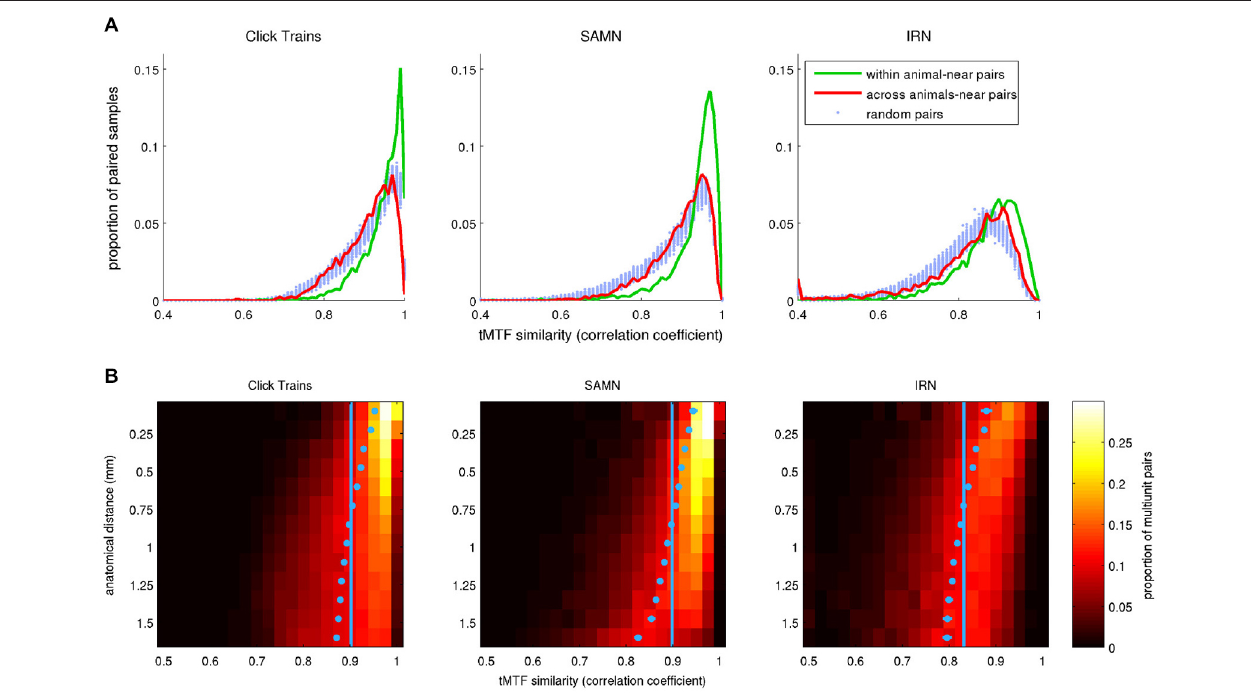
on anatomical distance. In the heat maps, each row shows the distribution of correlation coefficients for pairs of tuning curves recorded at points separated by an anatomical distance within 1/16 of a mm from the bin center shown on the y -axis. The light blue dots show the mean for each histogram. Their error bars cover a range of ± 3.3 SEM. Given the large N , some of the error bars may be too small to see. The light blue vertical lines demarcate the overall mean correlation coefficient across all sample pairs at all